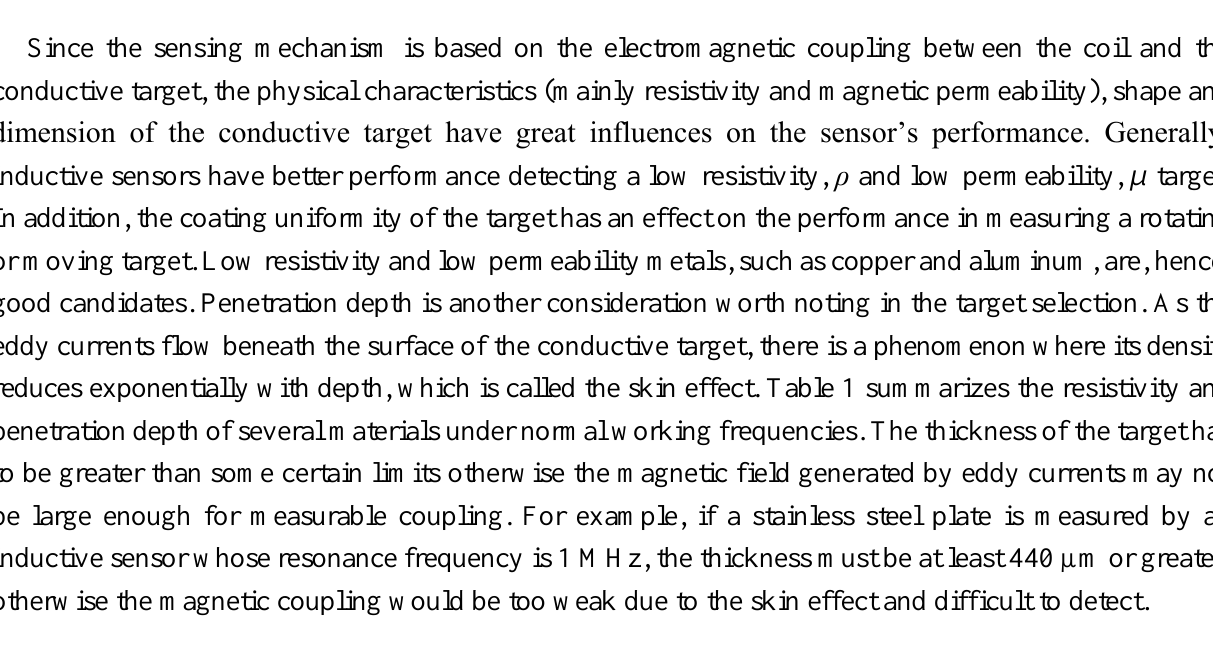
Table 1. Resistivity and penetration depth of typical target materials